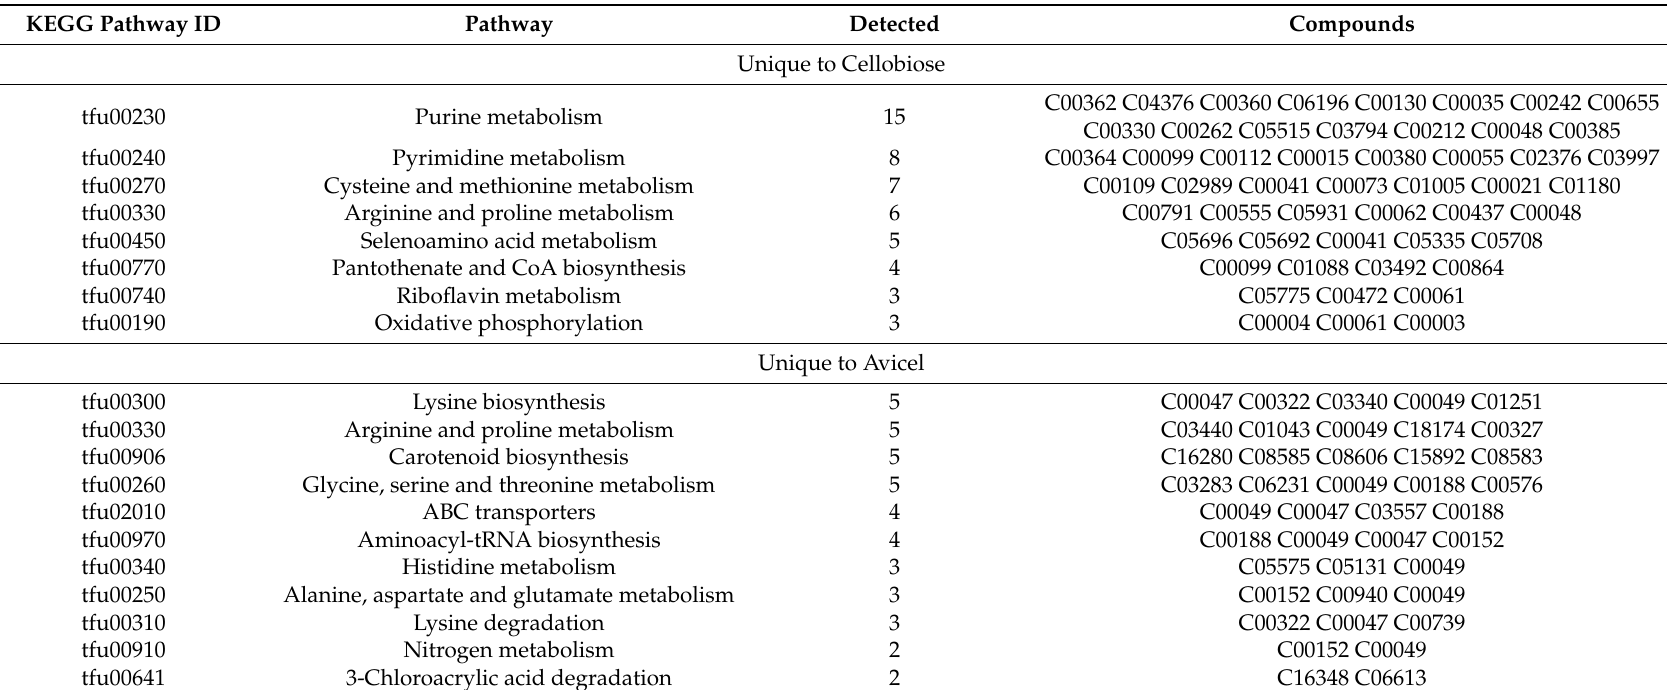
Table 3. Pathways associated with differentially detected compounds for growth on cellobiose vs.